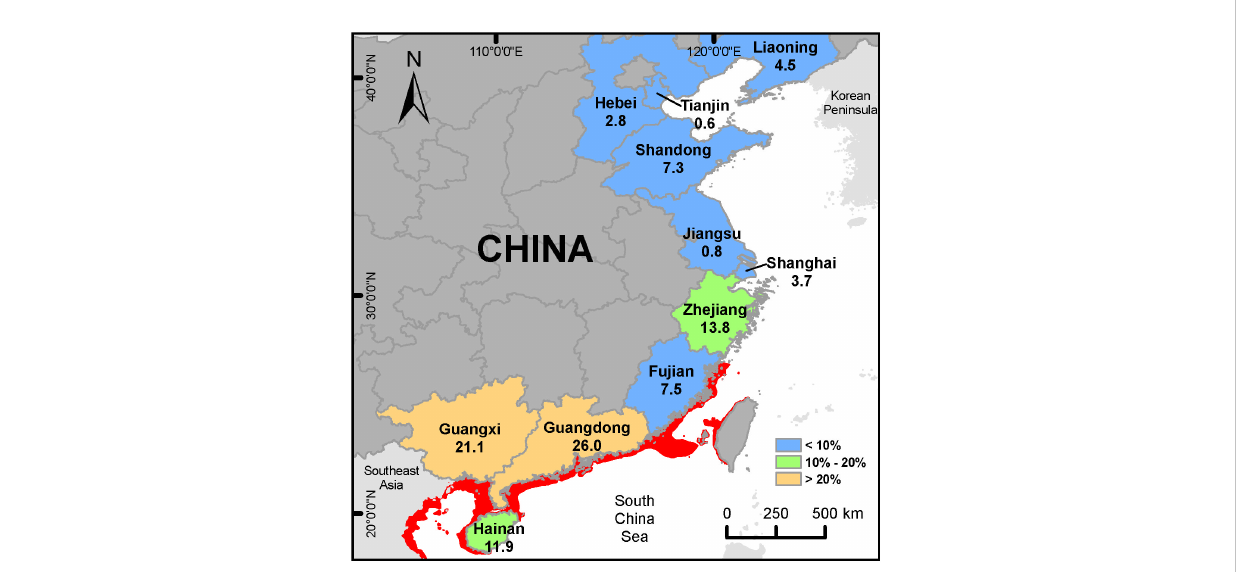
FIGURE 1 Geographic distribution of respondents (%) from different coastal provinces/regions/municipalities of China (except Hong Kong, Macao and Taiwan regions). The red area shows the distribution range of threatened seahorses and horseshoe crabs, which is consistent with the most frequently reported taxa by the respondents subjected to possible illegal marine wildlife exploitation activity. Geographic range data of the taxa are obtained from the IUCN Red List of Threatened Species, Version